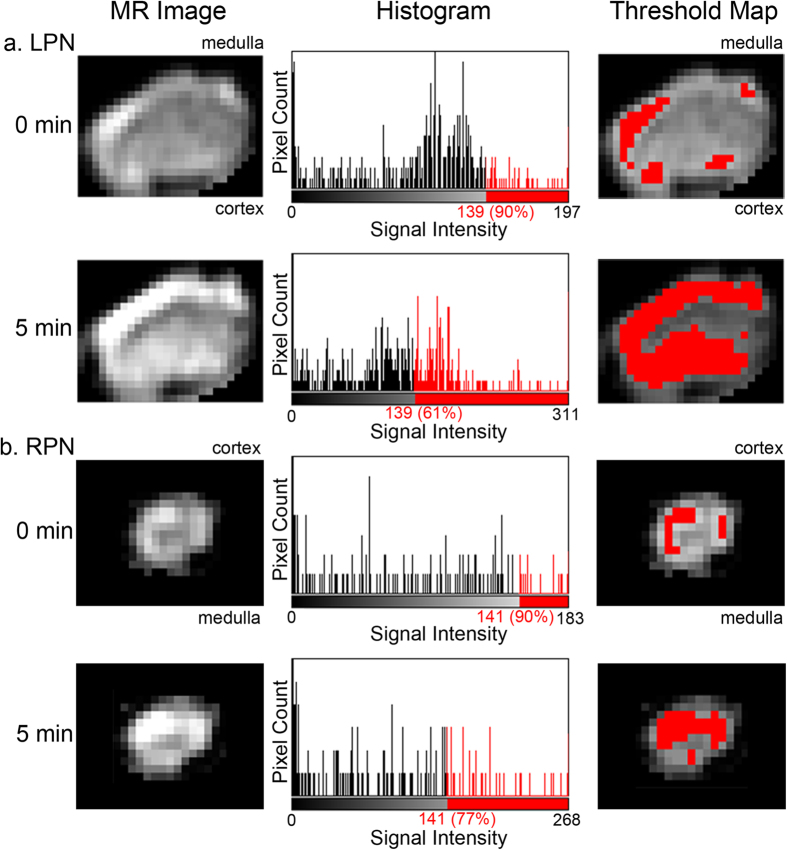
Hot-spot analysis of contrast agent uptake into the popliteal lymph nodes.For each LN, histogram analysis was used to determine the 90th percentile pre-contrast threshold, and to select only post-contrast voxels above the same threshold value for integrated density calculations and analysis. Shown are representative MR images before (0 min) and after (5 min) Gd-LNP injection (left panels), associated LN signal intensity histograms (center panels), and thresholded maps (right panels). (a) In the LPN, the 90th percentile pre-contrast value of 139 was determined from the histogram, which corresponded to the 61st percentile of 5 min post-contrast pixel values. Pixels with values above 139 and included in this analysis are shown in red on threshold maps. (b) The process was repeated for the RPN, where the 90th percentile pre-contrast value was 141, which corresponded to the 77th percentile of 5 min post-contrast pixel values.